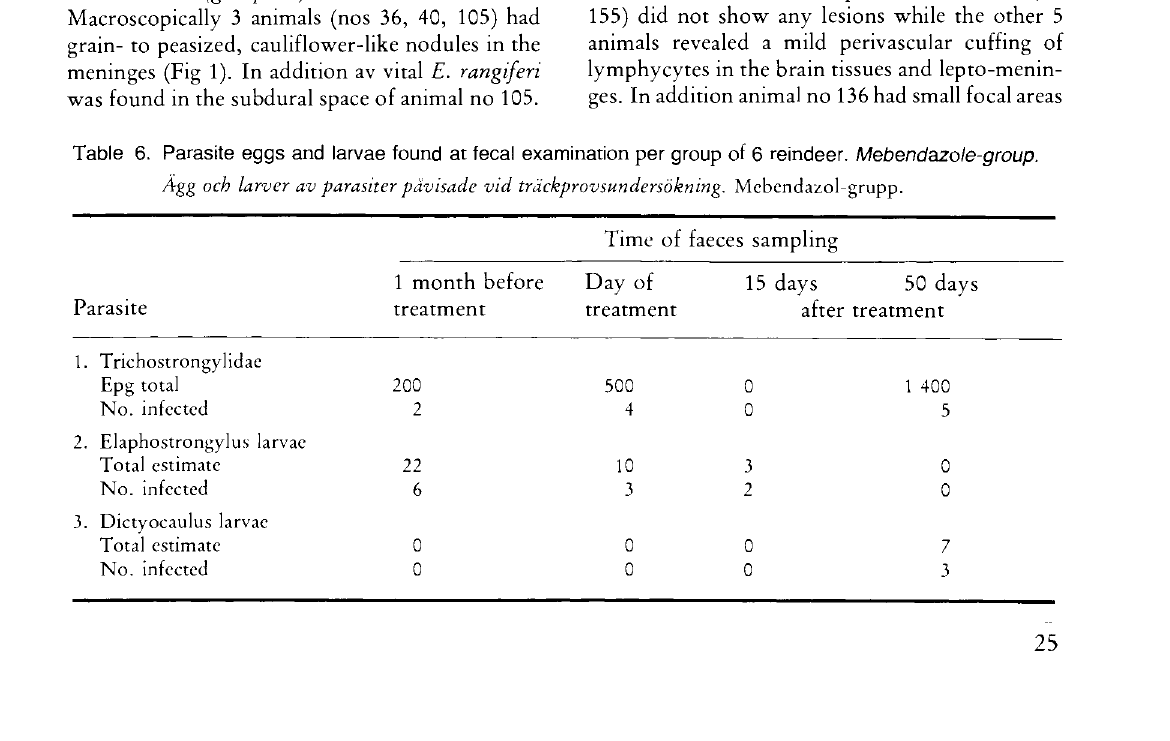
Table 6. Parasite eggs and larvae found at fecal examination per group of 6 reindeer.